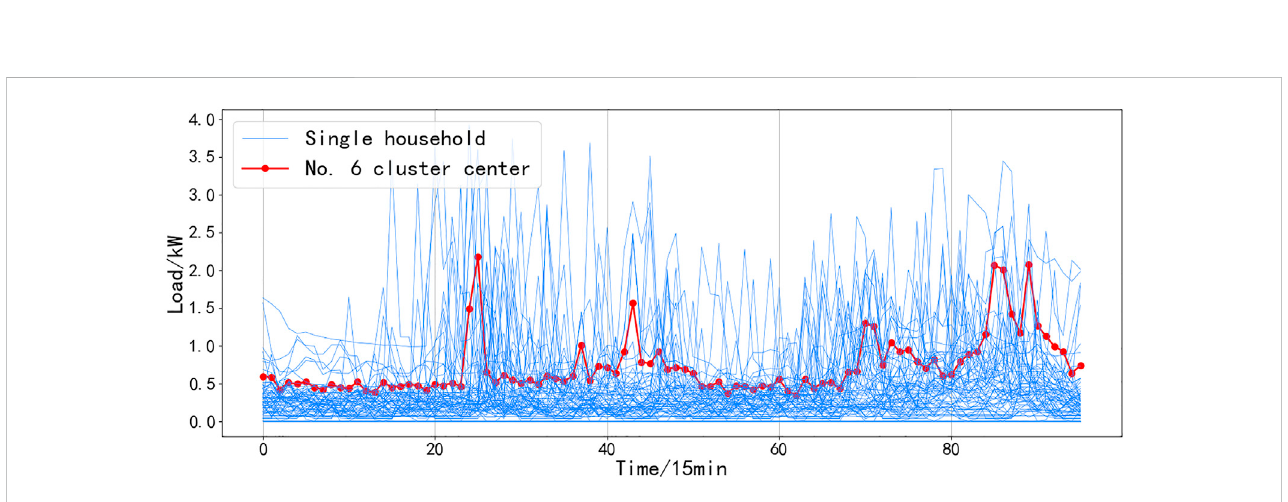
FIGURE 9 Category 1 of residential electricity mode and the clustering center of it.